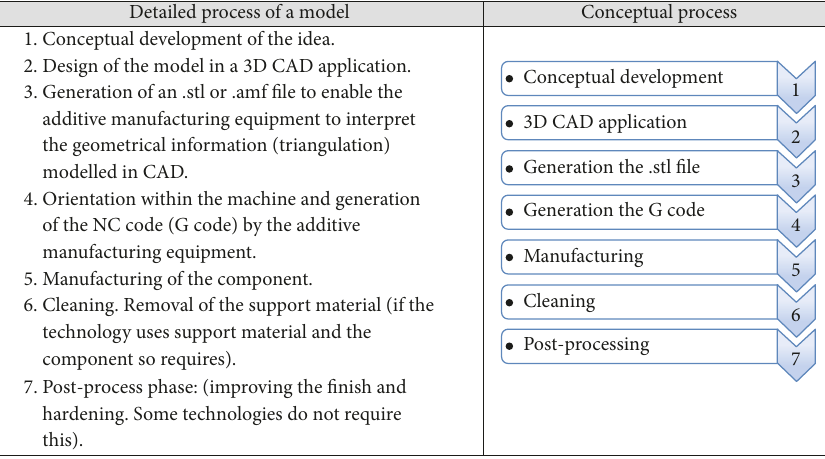
Figure 2: Phases of the additive manufacturing